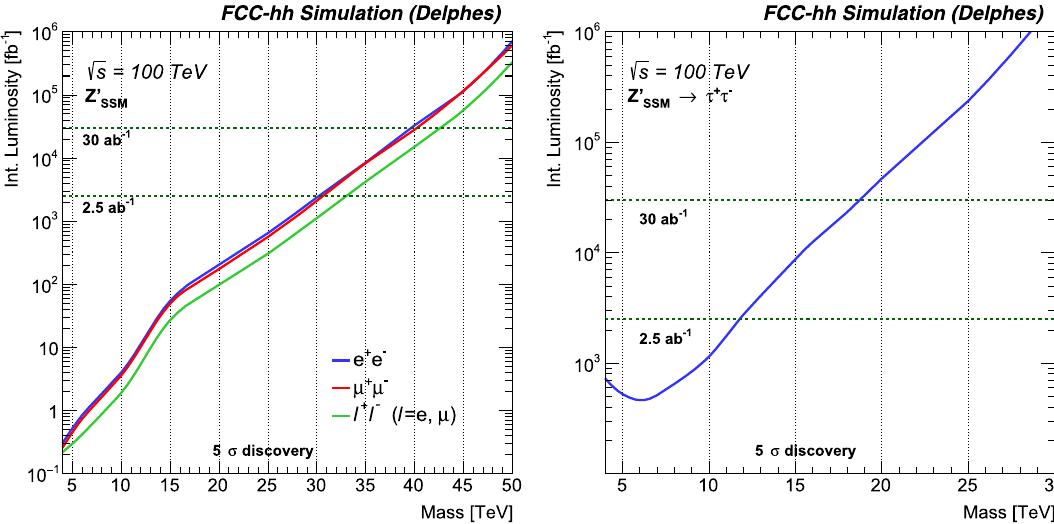
Fig. 4 Integrated luminosity versus mass for a 5 σ discovery, for e /μ final states (left) and for the τ final states